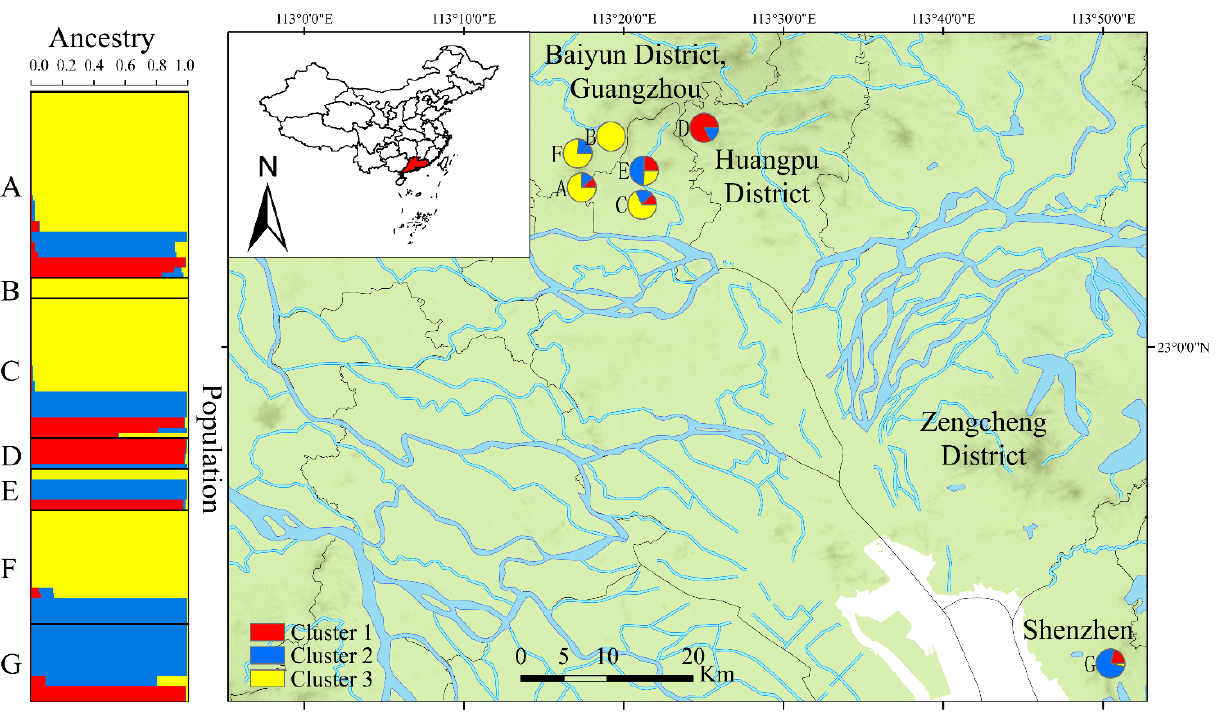
Figure 4. Locations and genetic structure of seven populations of A. exitialis . STRUCTURE clustering analysis results based on their geographic distribution on the left. Codes of the populations are given in Table 1.